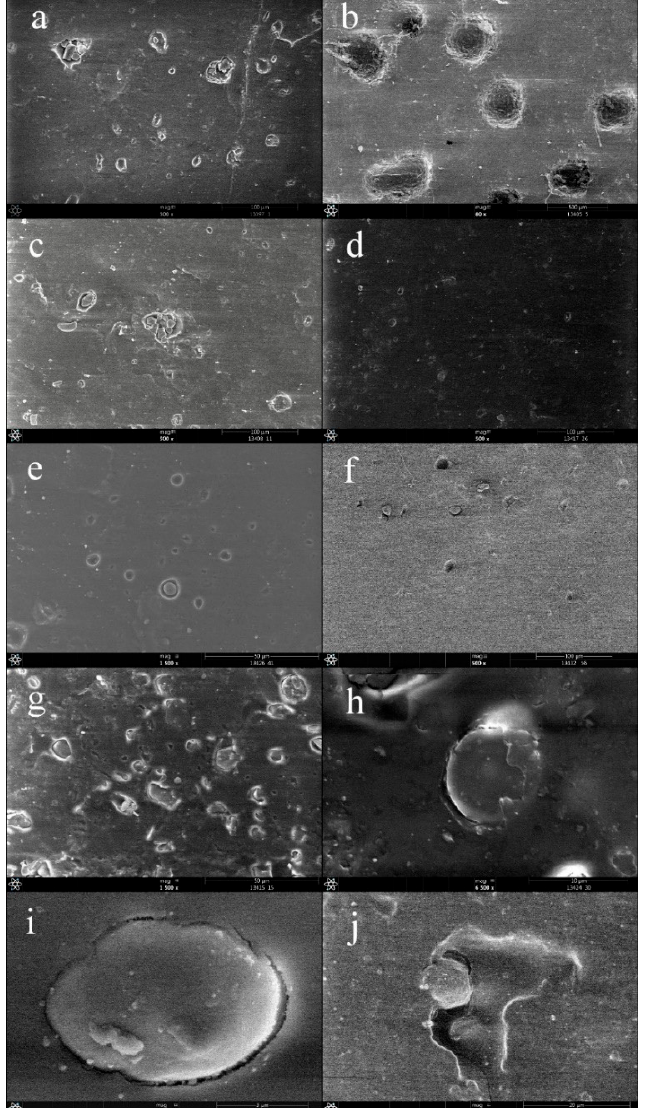
Figure 11. SEM images of compatibilized and uncompatibilised PLA/starch blends containing 10 and 50% starch (( a ) 90/10 PLA/starch without compatibilization, ( b ) 50/50 PLA/starch without compatibilization, ( c ) 90/10 PLA/starch with castor oil-based masterbatch, ( d ) 90/10 PLA/starch with rapeseed oil-based masterbatch, ( e ) 90/10 PLA/starch with sunflower oil-based masterbatch, ( f ) 90/10 PLA/starch with PLA-g-MA, ( g ) 50/50 PLA/starch with castor oil-based masterbatch, ( h ) 50/50 PLA/starch with rapeseed oil-based masterbatch, ( i ) 50/50 PLA/starch with sunflower oil-based masterbatch, ( j ) 50/50 PLA/starch with PLA-g-MA).